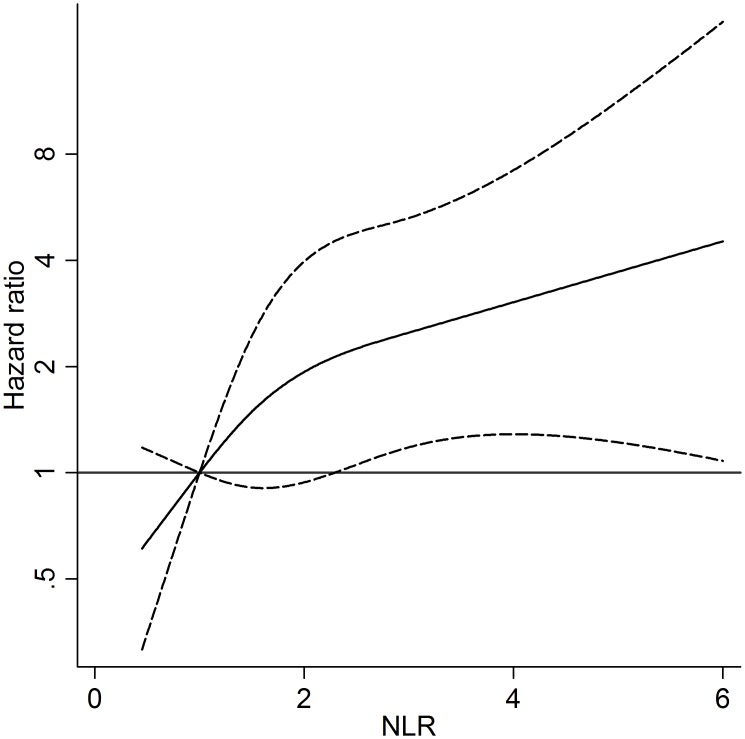
Risk of CVD event (Hazard Ratio) according to NLR distribution.NLR was modeled by cubic spline (solid line) with three knots in Cox regression model adjusted for age, sex, intravenous drug use, diabetes and tobacco smoking as fixed covariates, and CD4 cell count, antiretroviral therapy, presence of hypertension, SBP, total cholesterol and HDL as time dependent covariates. The reference value is 1.2. The 95% confidence intervals are shown as dashed lines. Vertical axes have a logarithmic scale. Abbreviations: NLR, neutrophil to lymphocyte ratio; SBP, systolic blood pressure; HDL, high density lipoprotein.